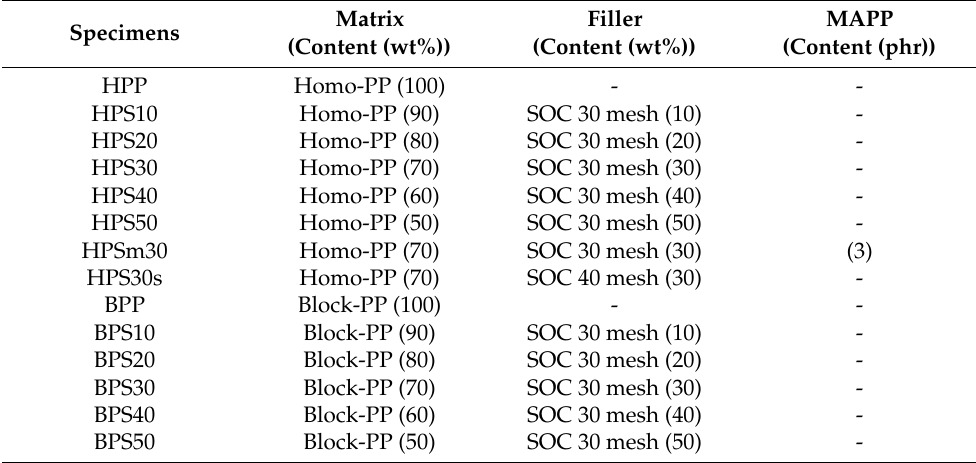
Table 4. Composition of PP/SOC